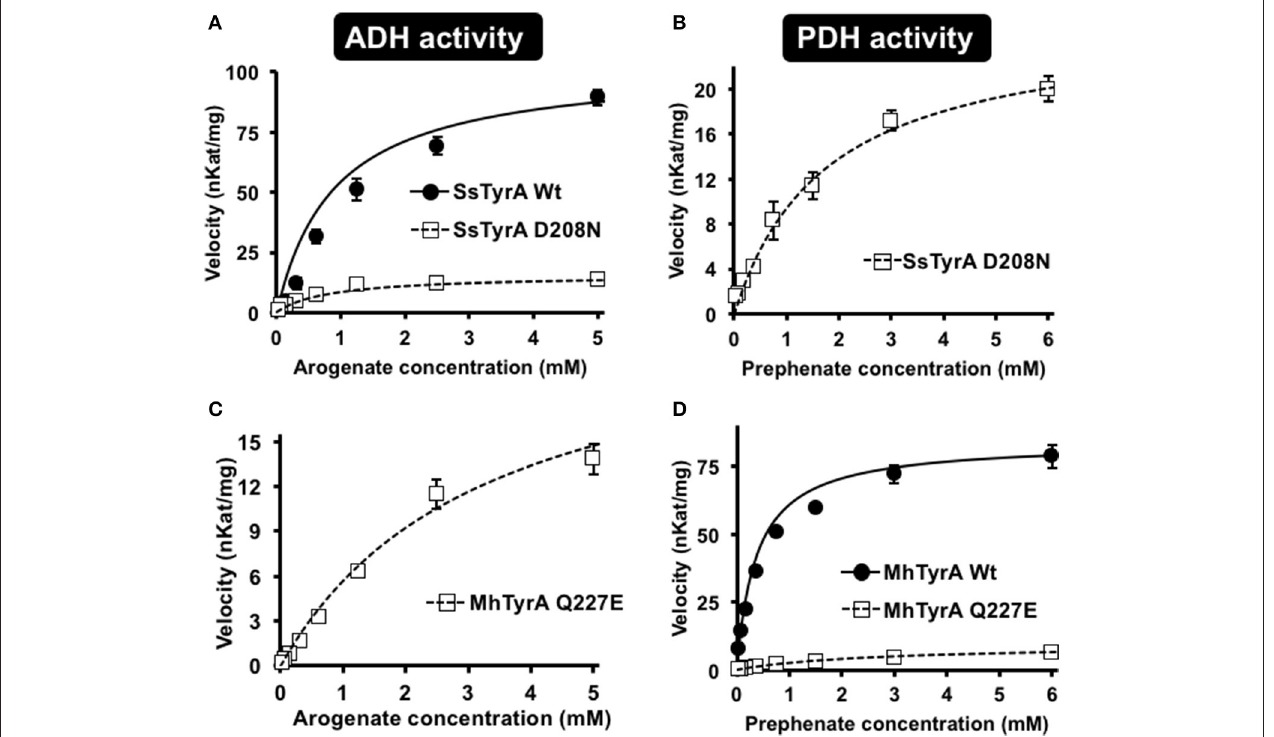
FIGURE 4 | Kinetic analysis of Wt and mutant enzymes of SsTyrA a and MhTyrA p . Kinetic analyses were performed with SsTyrA a Wt (filled circle) and D208N mutant (open square) enzymes with arogenate (A) and SsTyrA a D208N mutant (open square) with prephenate (B) . Kinetic analyses were also performed with MhTyrA p Wt (filled circle) and Q227E mutant (open square) enzymes using arogenate (C) and prephenate (D) . Initial velocity values at each substrate concentration were fit to the Michaelis-Menten equation using Origin software. Kinetic analyses were conducted for MhTyrA p Wt using 3.41 µ g of purified recombinant enzyme, and 4.56 and 2.28 µ g of purified recombinant Q227E using prephenate and arogenate, respectively. Kinetic analyses conducted for SsTyrA a Wt used 0.30 µ g of purified recombinant enzyme, and 0.39 µ g of purified recombinant D208N. Data are means ± SEM ( n = 3 independent experiments). Error bars smaller than symbols are not